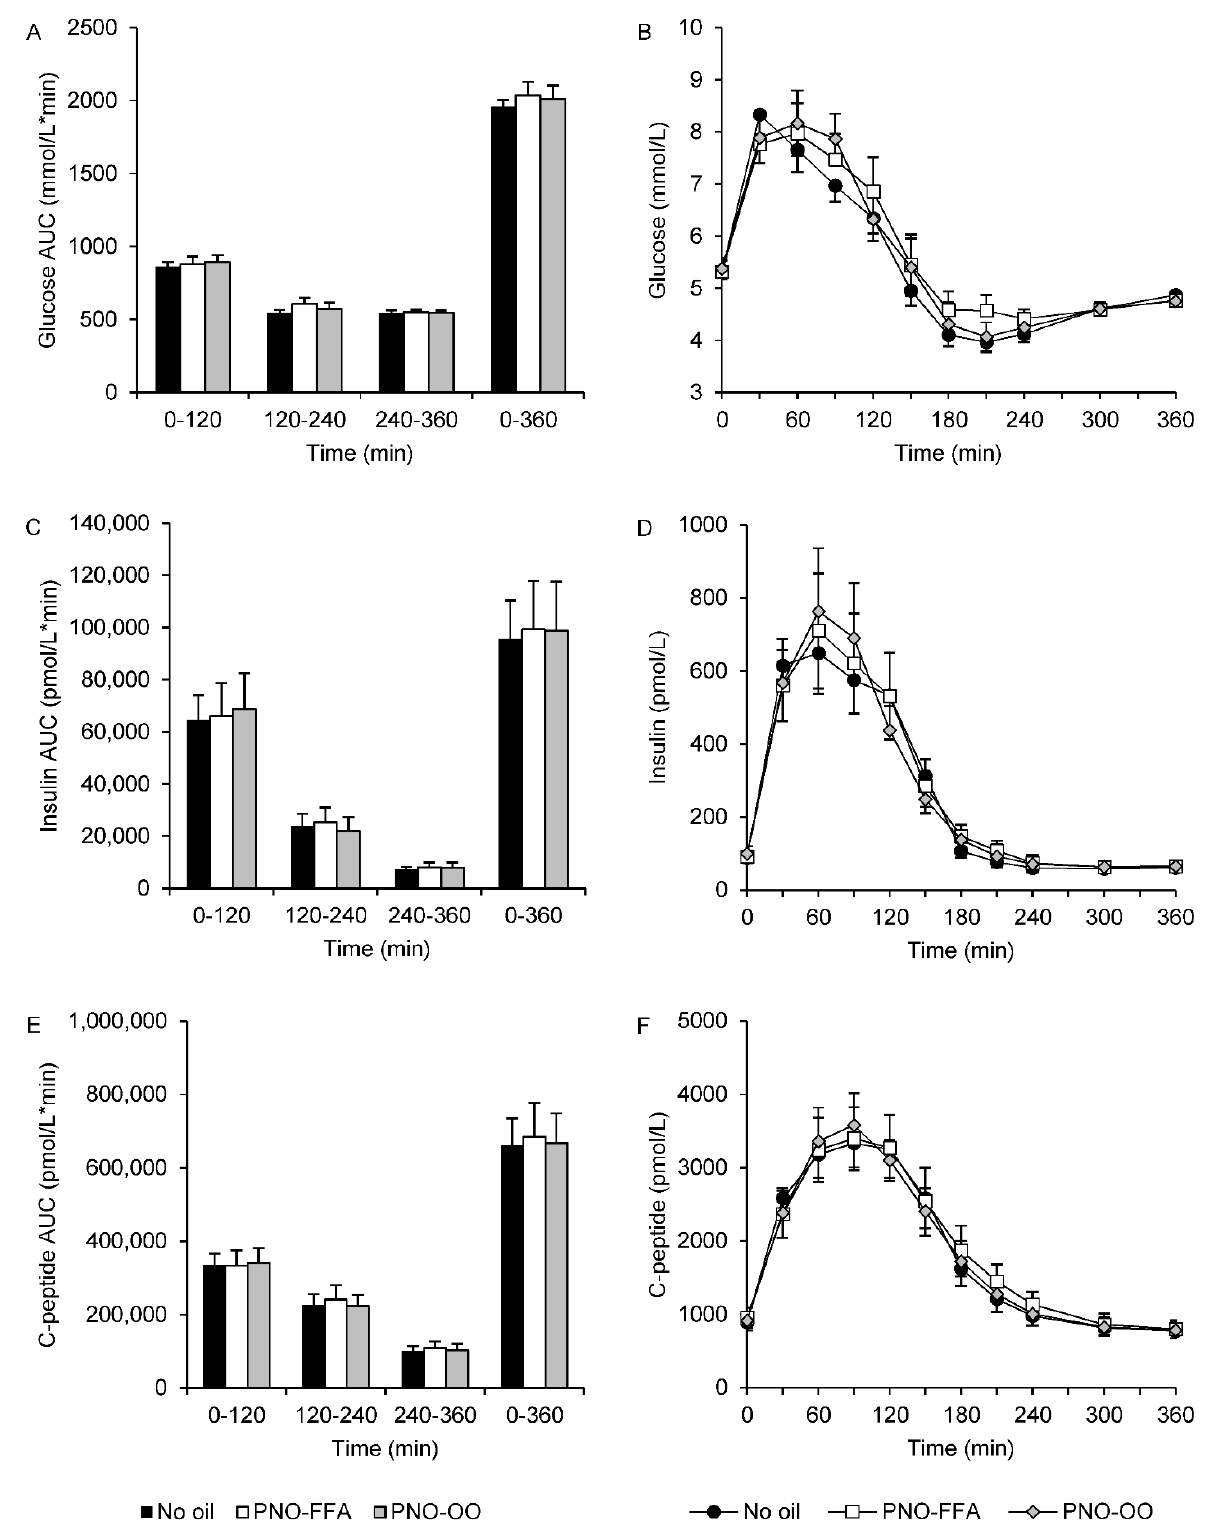
Figure 1. Glucose ( A , B ), insulin ( C , D ) and C-peptide ( E , F ) levels during a 6-h OGTT and their corresponding area under the curve calculated for 0–120, 120–240, 240–360 and 0–360 min in response to glucose alone (no oil, black bars and black circles), 6 g hydrolyzed pine nut oil (PNO-FFA, white bars and white squares) or 3 g hydrolyzed pine nut oil and 3 g olive oil (PNO-OO, gray bars and gray diamonds). Data are mean ± SEM.